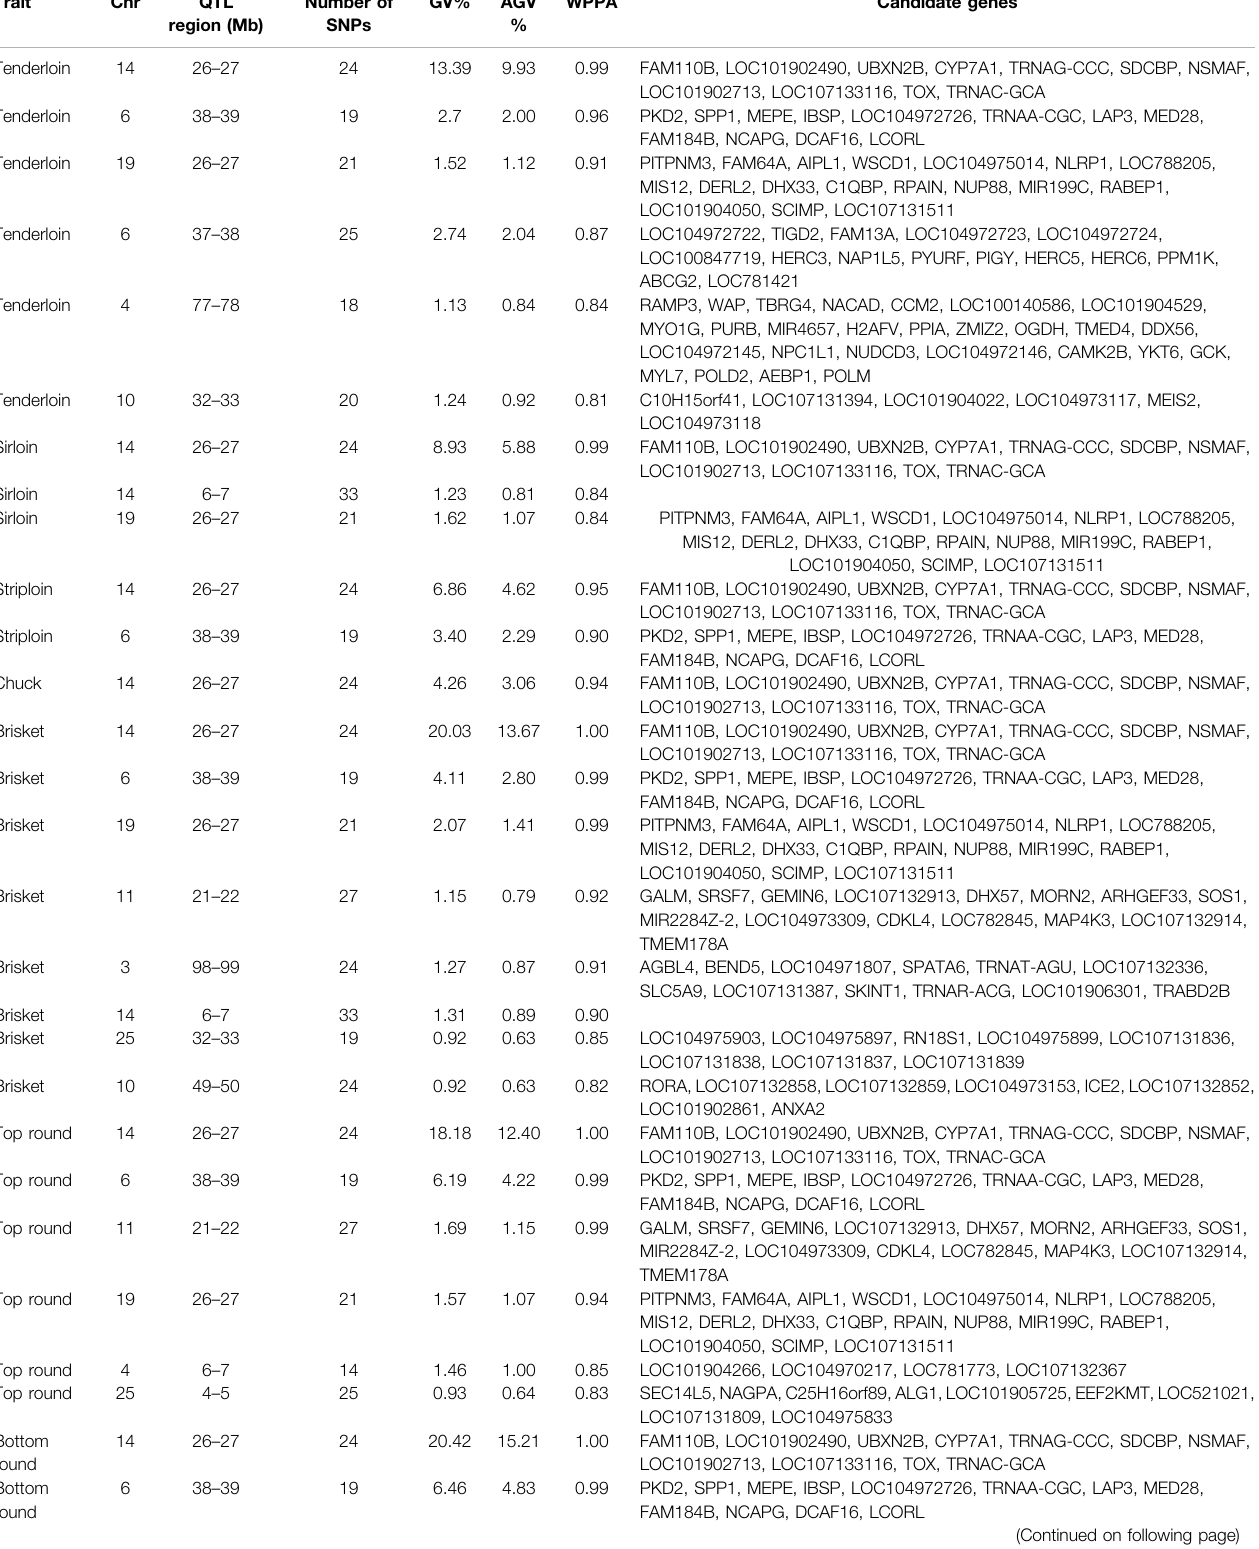
TABLE 2 | Gene identi fi cation and proportion of variance explained by 1-Mb windows associated with the primal cut traits in Hanwoo cattle.